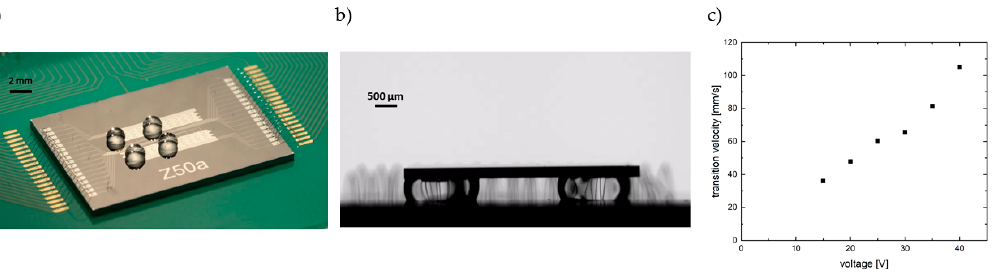
Figure 17. ( a ) four droplets in their initial positions on the two electrode arrays; ( b ) four droplets on the electrode arrays serving as liquid bearings, carrying a 220 µm thick silicon platform; ( c ) Transition velocity of one single liquid bearing without a payload between two electrodes, as a function of the applied voltage.